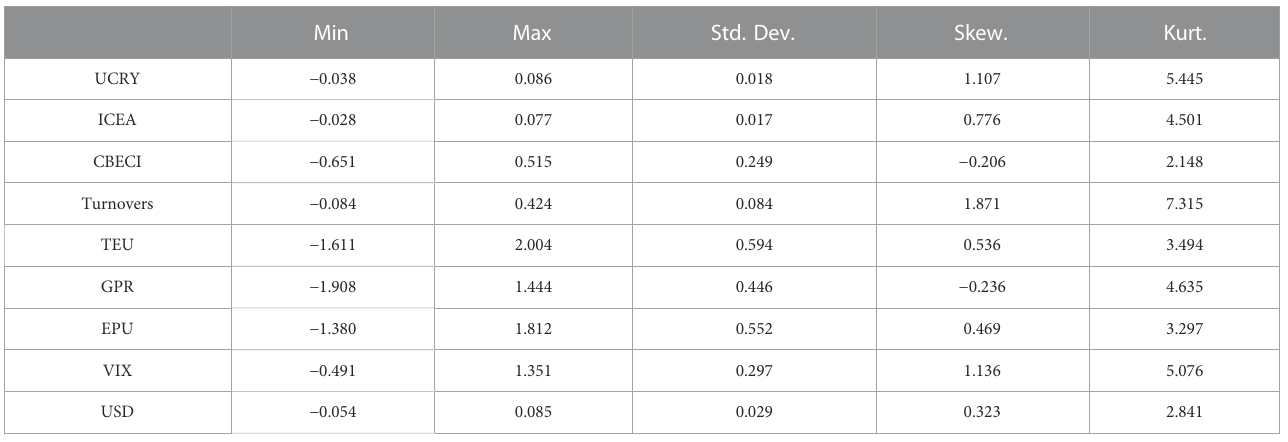
TABLE 2 Statistics on the potential drivers of